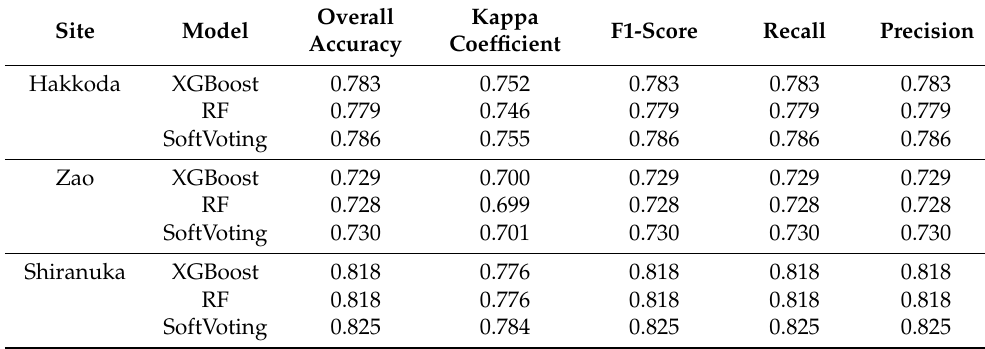
Table 5. Performance of the very high-resolution suite using bi-seasonal images.